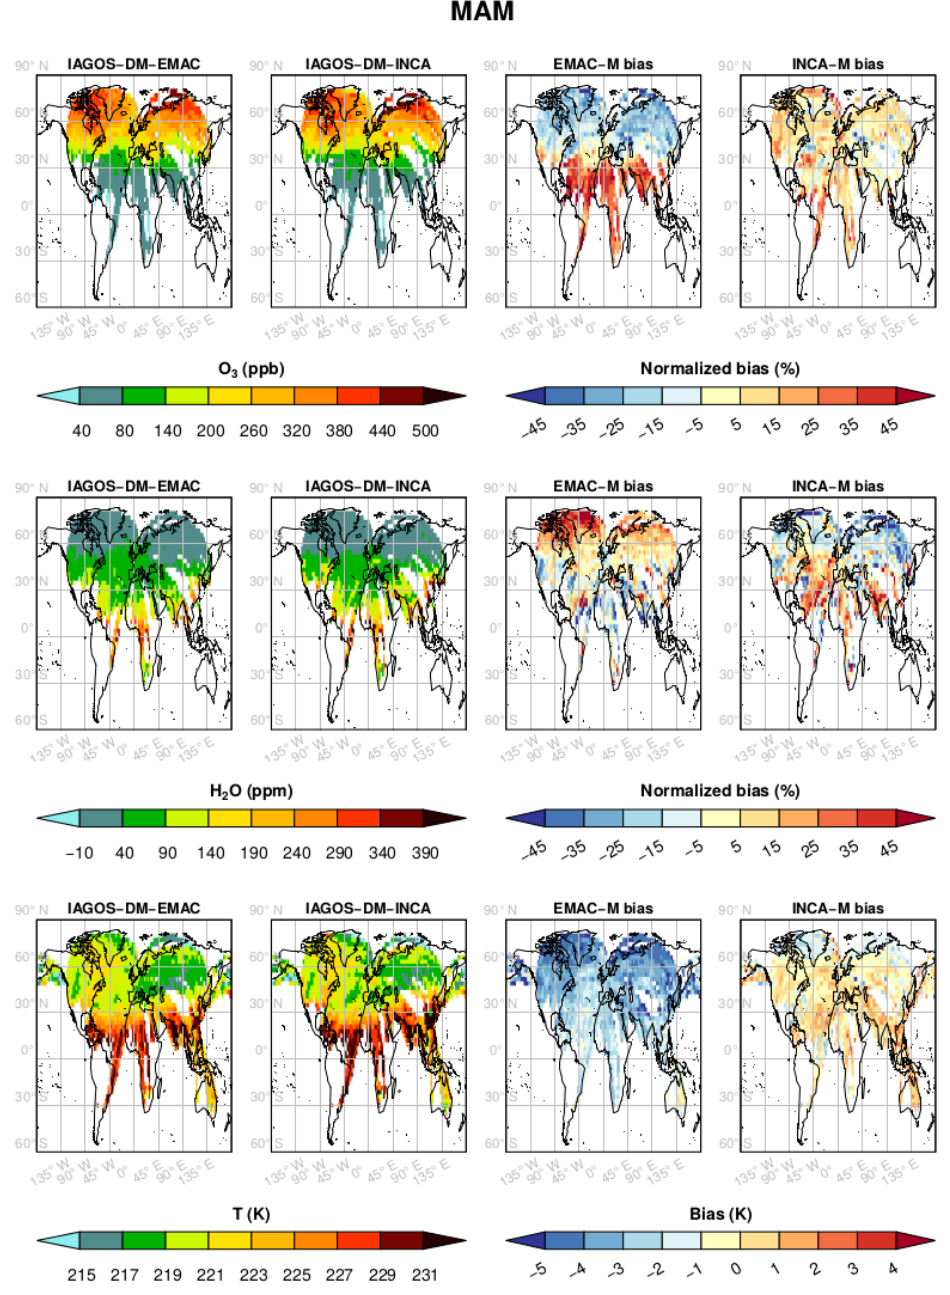
Figure A10. Same as Fig. A8 for boreal